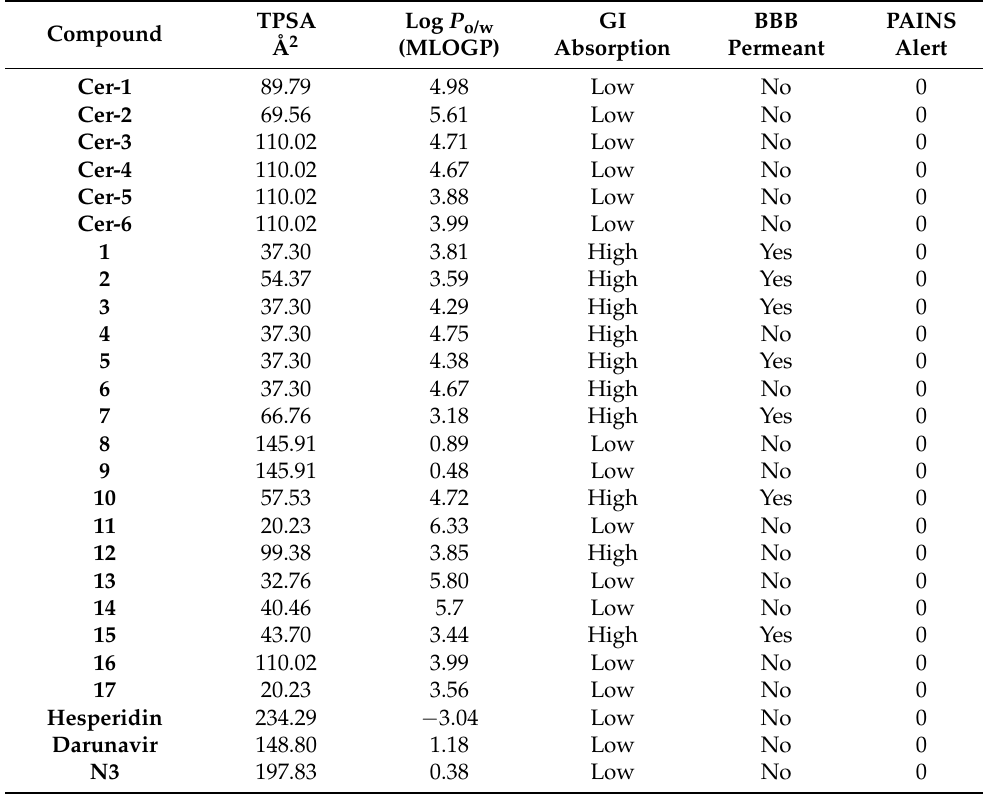
Table 6. Physicochemical parameters and ADME of isolated ceramides, compounds 1–17 , hesperidin, darunavir and